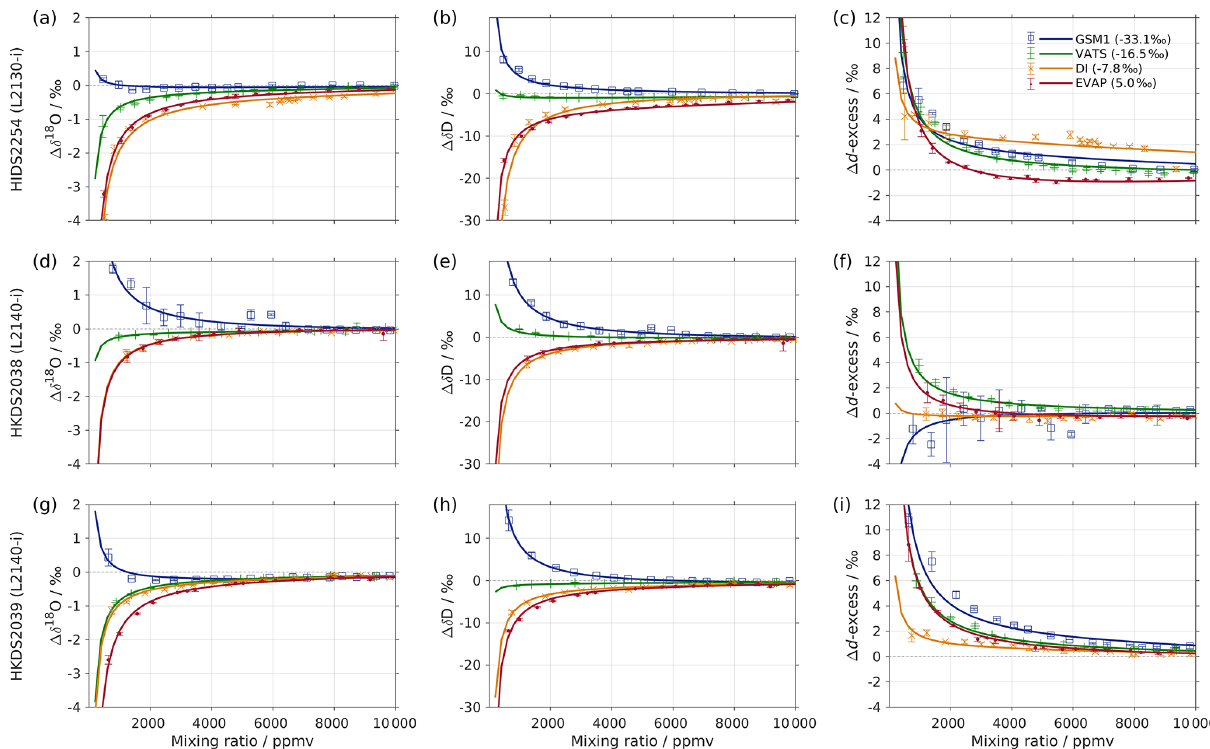
Figure A2. Mixing ratio dependency of uncalibrated measurements for instruments (a–c) HIDS2254, (d–f) HKDS2038, and (g– i) HKDS2039. The measurements are carried out with discrete injections by using an autosampler with N 2 as the carrier gas (experiments 3, 9, and 14). Only the data below 10000ppmv are shown. Symbols and solid lines indicate measurements and fits, respectively, as in Fig.